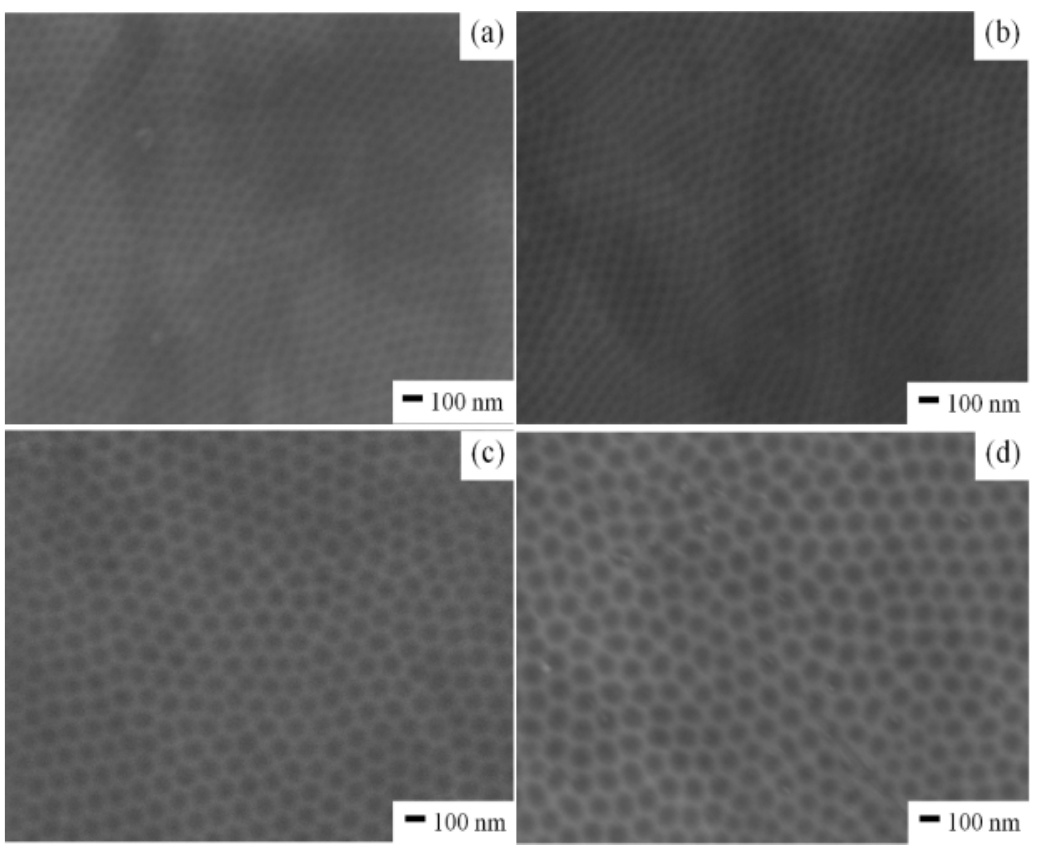
Figure 3. Morphologies of anodic oxidation stainless steel electrode in the ethylene glycol electrolyte containing HClO 4 at potentials of 20 ( a ), 30 ( b ), 40 ( b ) and 50 V ( d ).